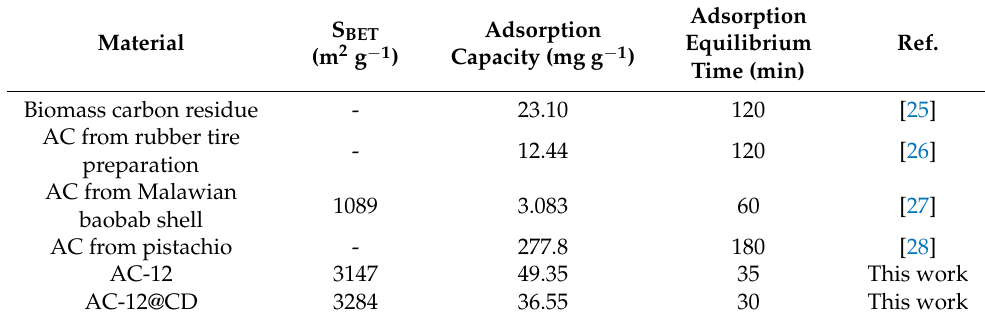
Figure 5. ( a ) Isothermal adsorption curve, ( b ) kinetic adsorption curve, ( c ) Freundlich curve, ( d ) Langmuir curve, ( e ) quasi-first-order kinetic curve, ( f ) quasi-second-order kinetic curve. Table 2. Comparison of a few reported materials for adsorption of Cu 2+